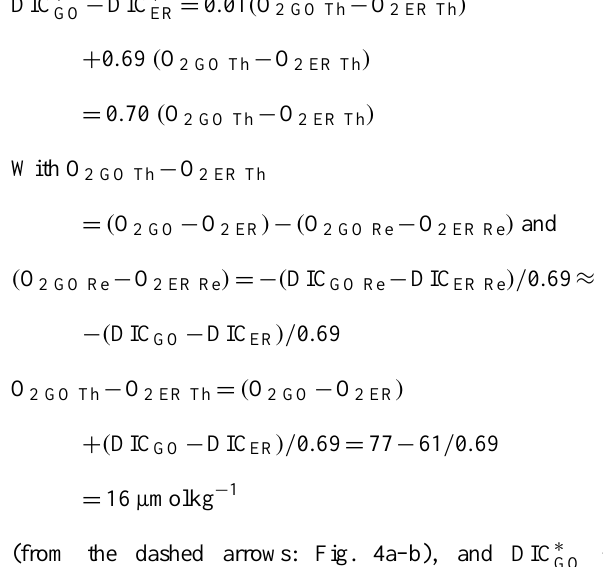
(from the dashed arrows: Fig. 4a–b), and DIC ∗ DIC ∗ = 0.70 × 16 ≈ 11 µmol kg − 1 as expected from the di- ER rect